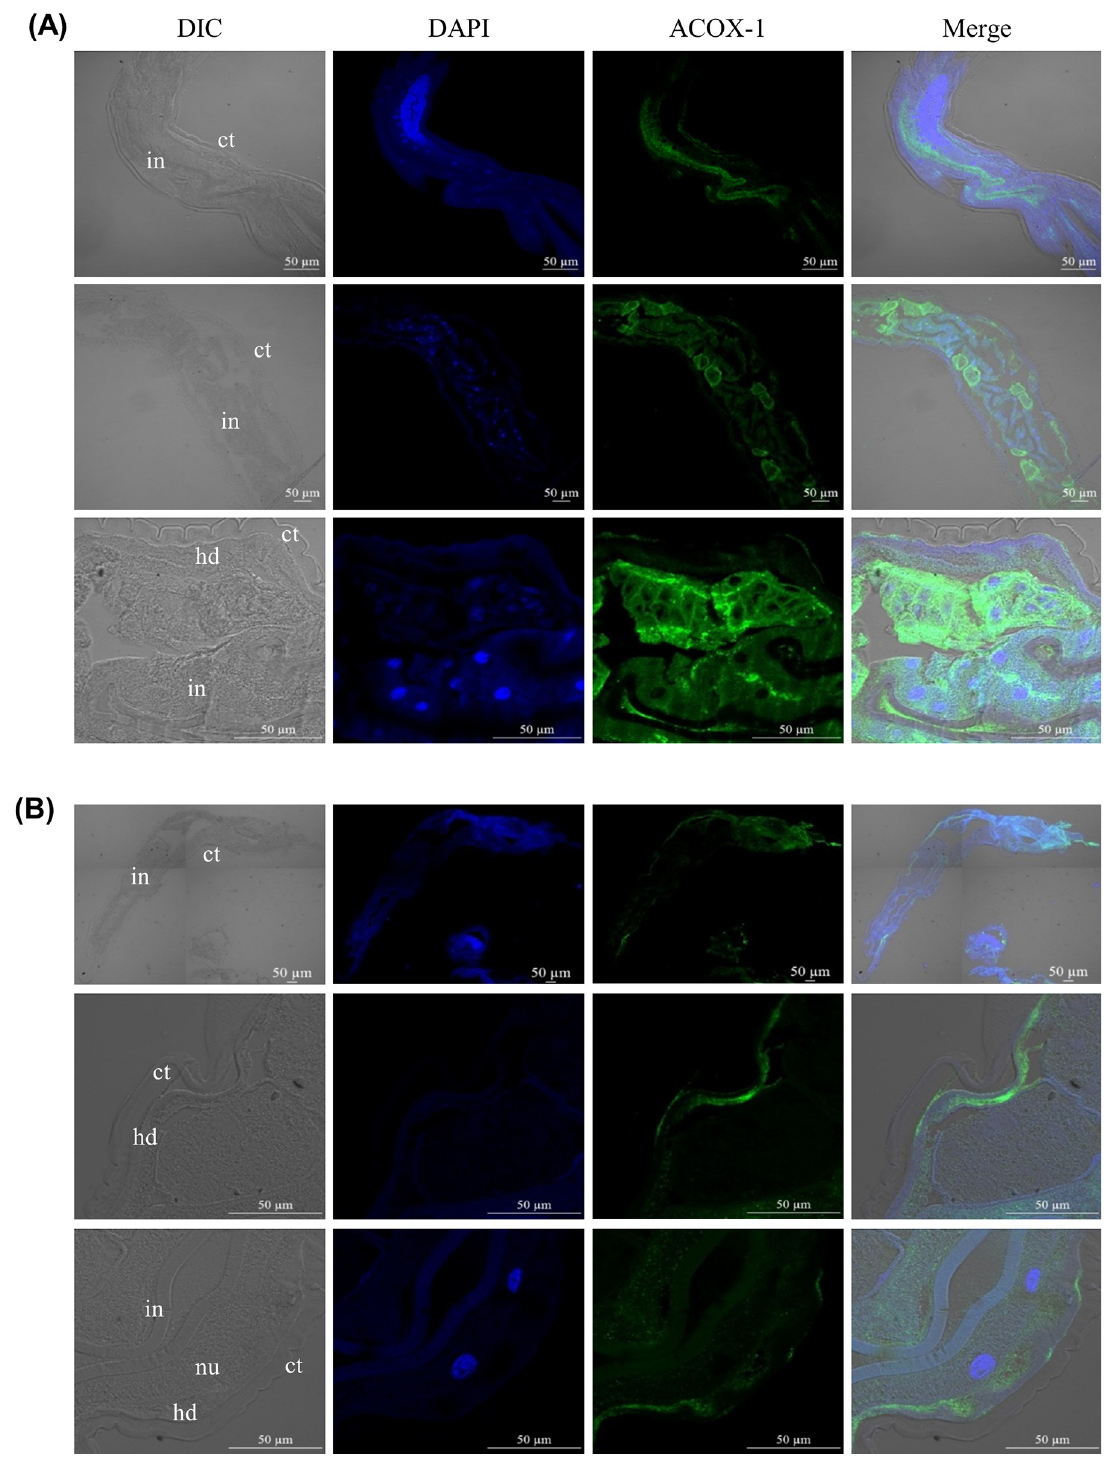
Fig 5. Tissue immunolocalisation of Hc -ACOX-1 in the fourth-stage larvae (L4s) and adult of Haemonchus contortus . Tissues of L4s (A) and female adults (B) of H . contortus are probed with rabbit anti-r Hc -ACOX-1.1 polyclonal antibodies followed by fluorescein conjugated-goat anti-rabbit IgG (H+L) as secondary antibody. Nuclei are counterstained with 4’,6-diamidino-2-phenylindole (DAPI). DIC: differential interference contrast, ct: cuticle, in: intestine, hd: hypodermis, nu: nucleus. Sections incubated with pre-immune serum (negative control) are provided in supplementary S5B Fig. Scale bar: 50 μ